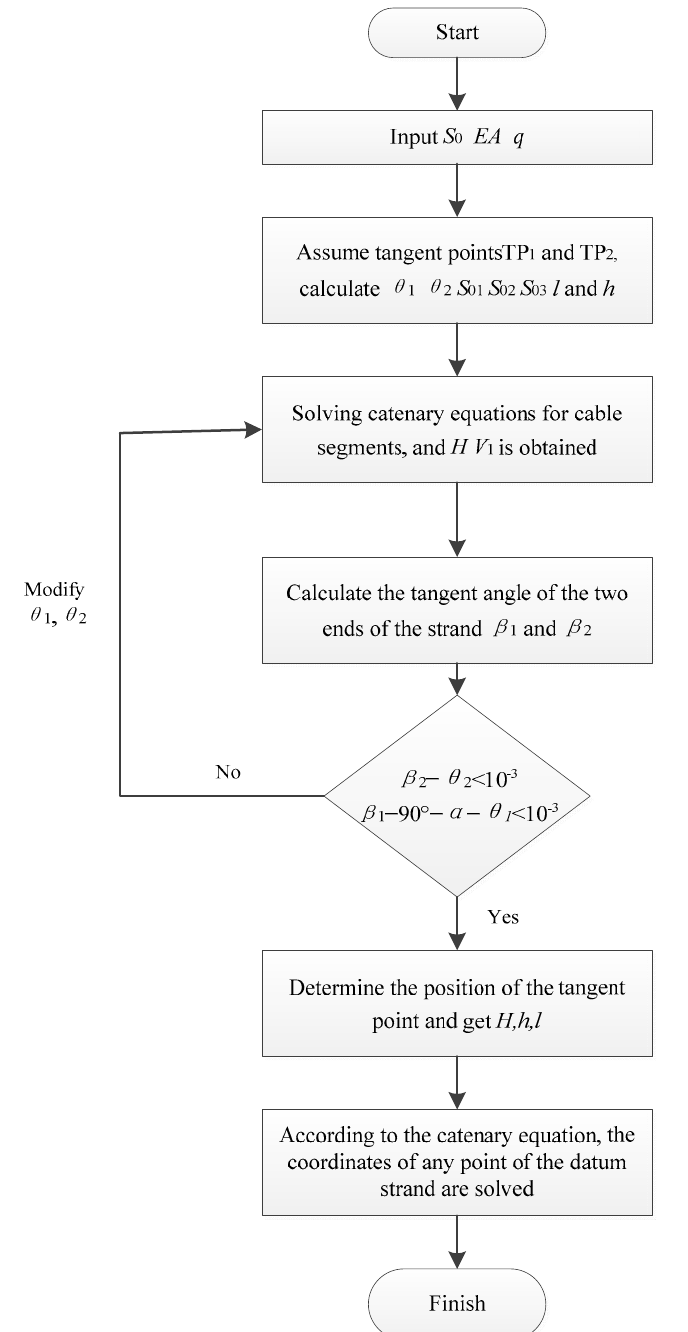
Figure 9. Calculation process of cable strand geometric shape considering the change in tangent point.